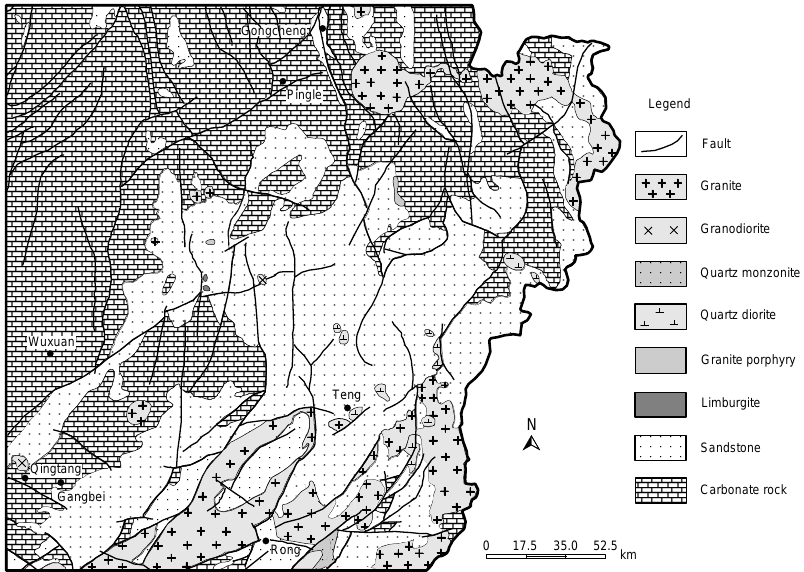
Figure 2. Regional geological map showing the location of FSM in Guangxi study area.